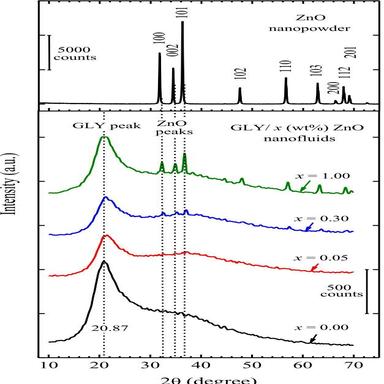
XRD patterns of the ZnO nanopowder and the GLY/x (wt%) ZnO nanofluids (x = 0.00, 0.05, 0.30, and 1.00).